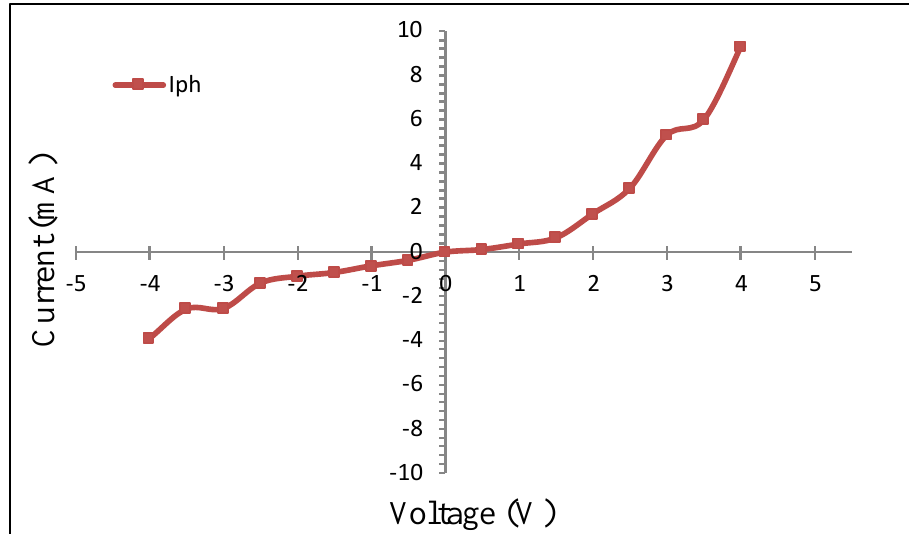
Figure 7: shows I-V characteristics for FeS 2 /CdO